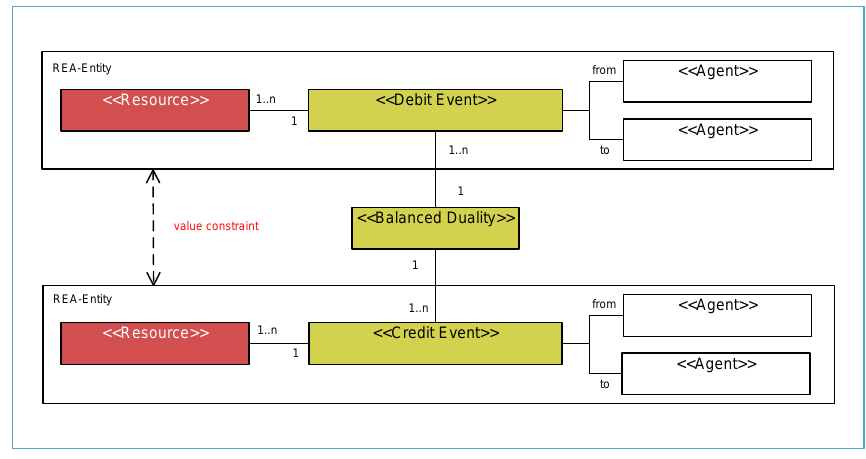
Figure 8. Reified Balanced Duality relationship – UML language